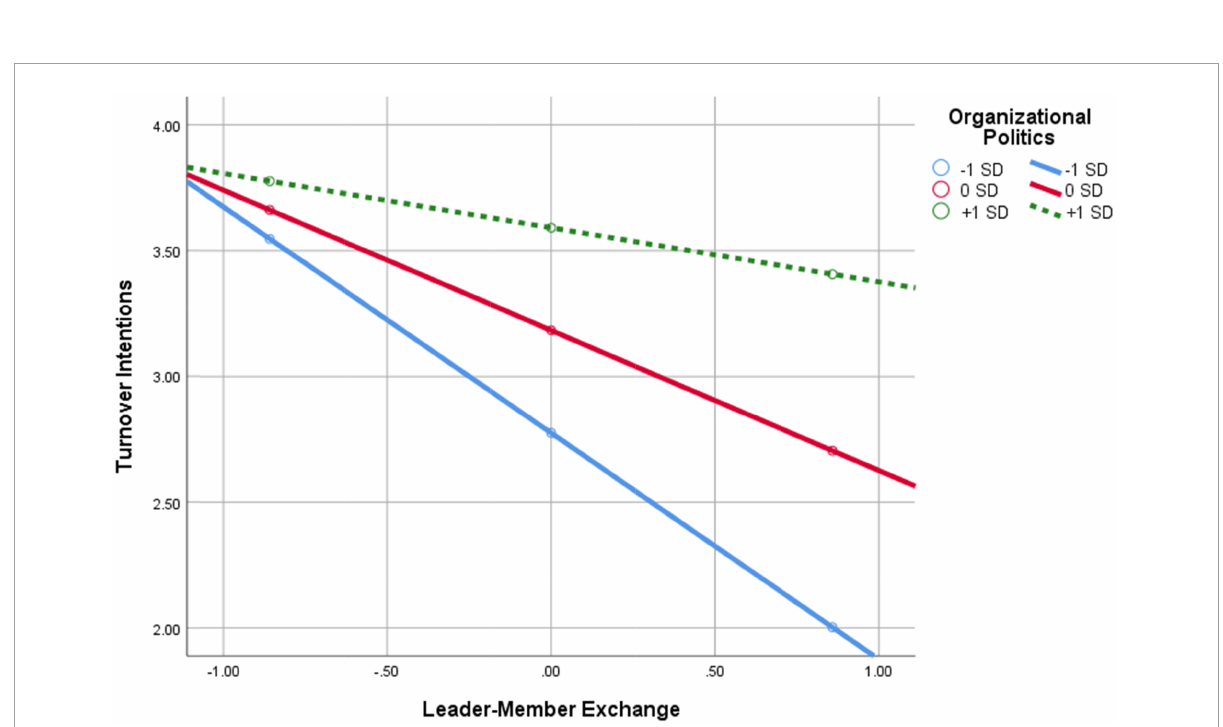
FIGURE6 Interaction of leader–member exchange × perception of organizational politics in predicting turnover